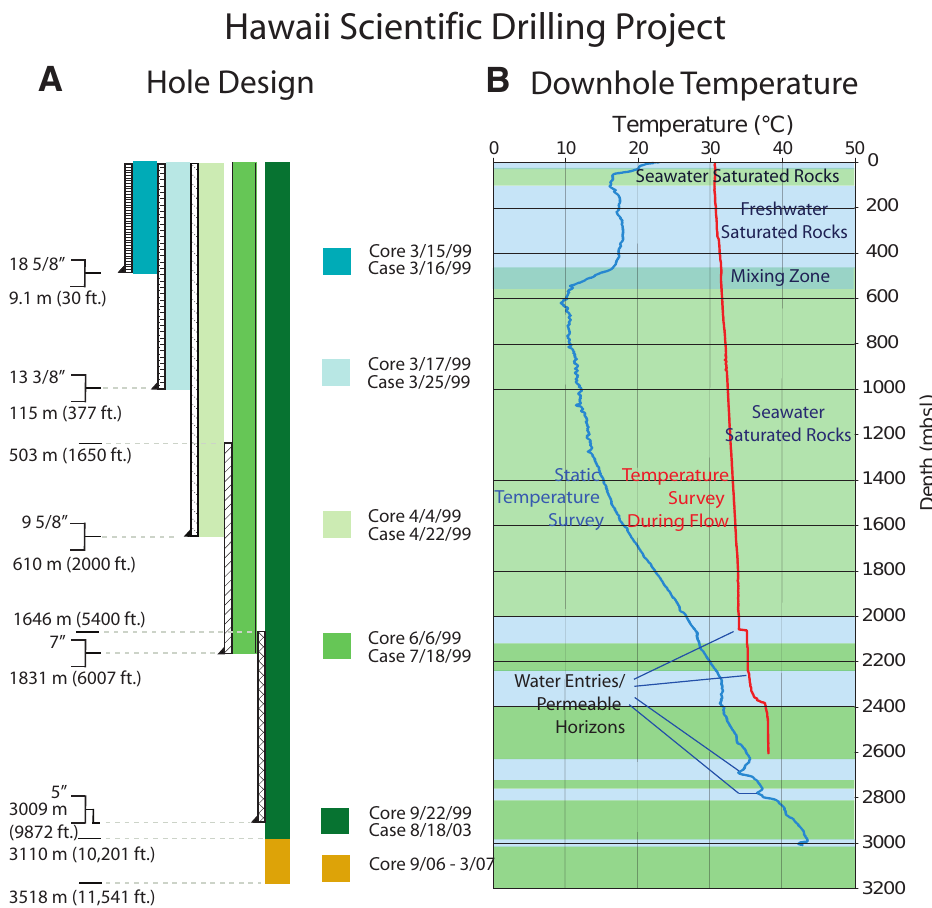
Figure 2. [A] Diagram showing the casing diameter in the HSDP2 hole, and the dates when coring and hole opening were done. Presently the hole is cased to a depth of 2997 mbsl, and is open below that. [B] Temperature measured in the hole and the inferred relationships to subsurface hydrological features. Freshwater is shown as light blue, seawater as light green, and brackish waters as intermediate colors. Temperature survey (red line), done while the hole was flowing and still uncased below 1820 mbsl, suggests that water is entering the hole below ~2800 mbsl, and additional entry levels are at 2370 and 2050 mbsl. Circulation of cold seawater through the section below 600 mbsl is rapid enough to cool the rocks to temperatures 15°C–20°C below a normal geothermal gradient.